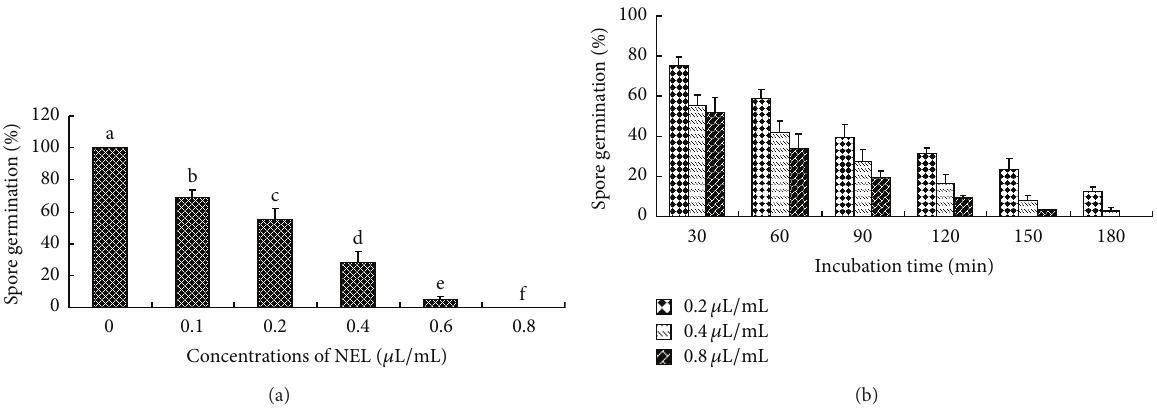
Figure 3: Effects of NEL on spore germination of A. flavus . (a) Effects of different concentrations of NEL on spore germination of tested fungi. (b) Growth kinetics of the inhibition of the tested fungi by